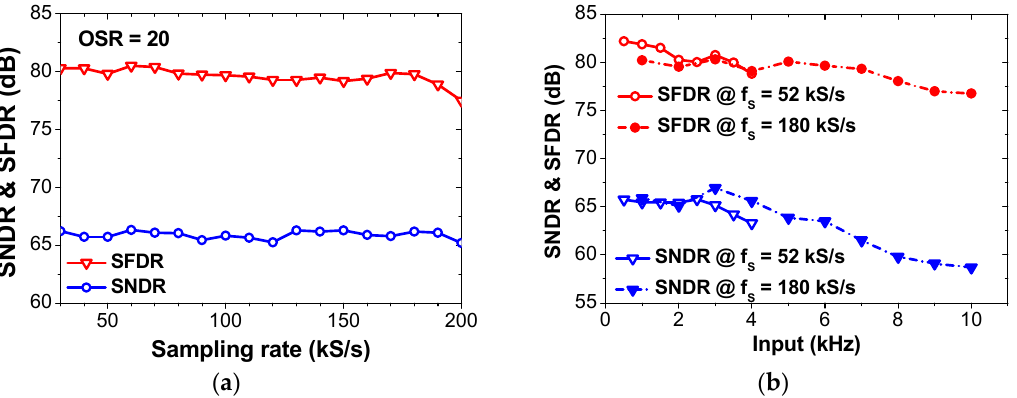
Figure 14. ( a ) Measured SNDR and SFDR as a function of the sampling rate. ( b ) Measured SNDR and SFDR as a function of the input frequency.